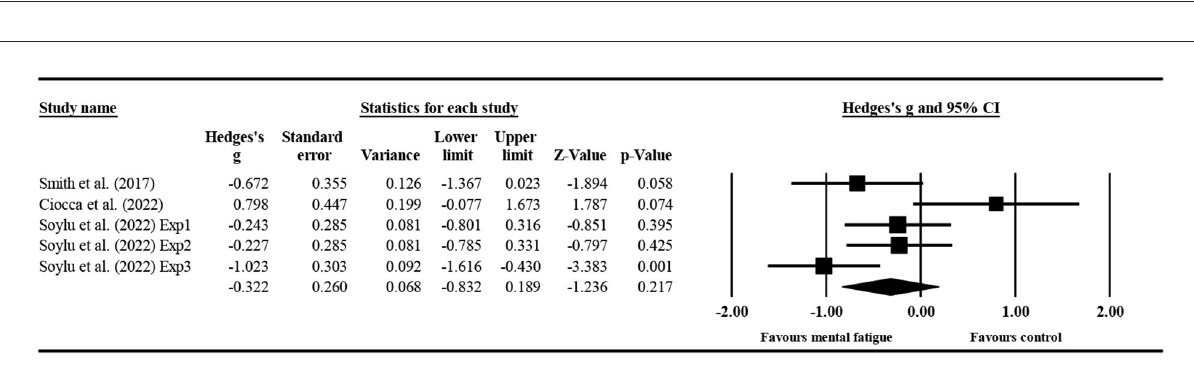
FIGURE5 Forest plot of changes in the number of successful passes with the comparison of two conditions (mental fatigue and control condition). The results displayed are effect sizes with 95%